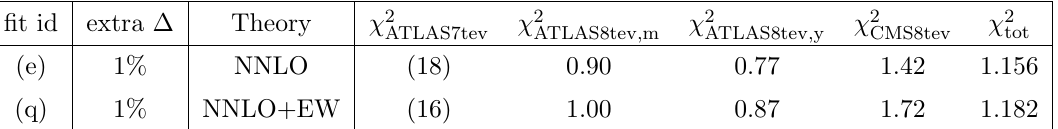
8 TeV (cid:12)t. T